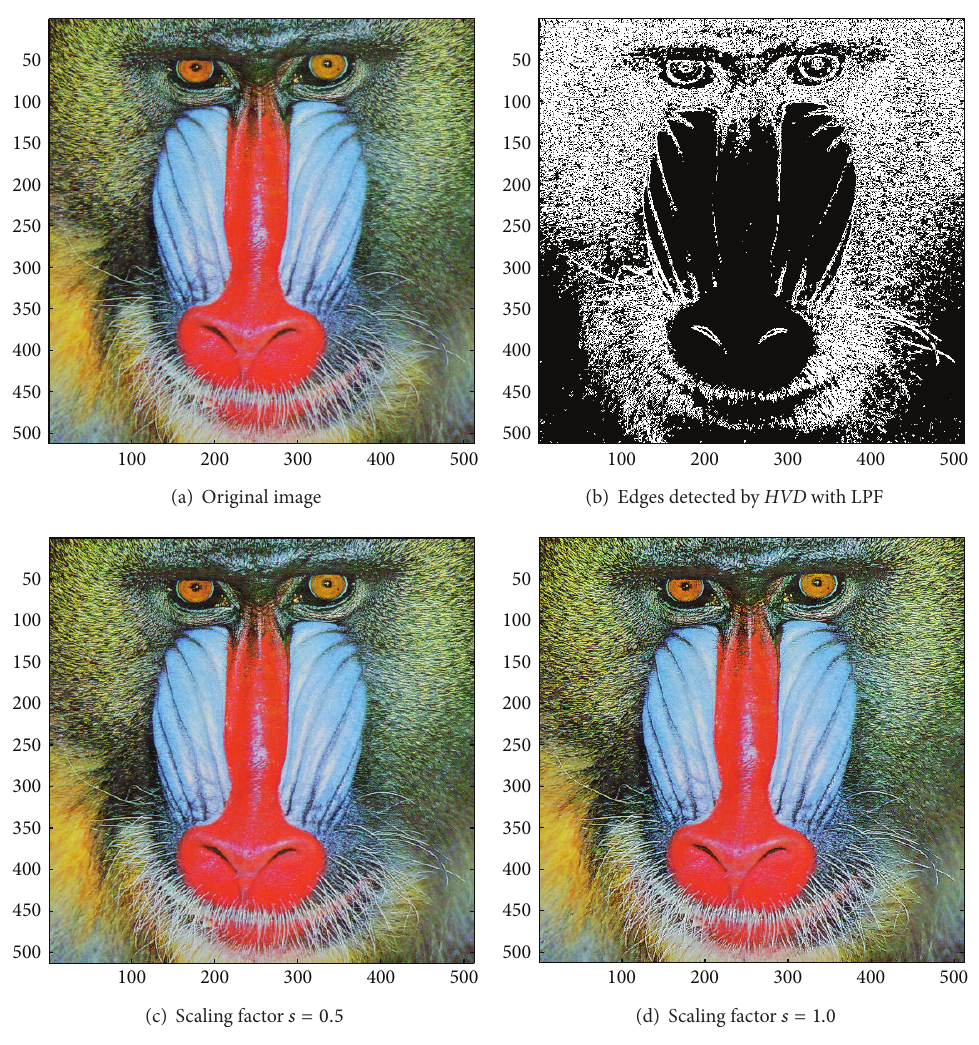
= 16 for HVD . (a) The image “Baboon” (512 × 512 color image). (b) Edges detected by HVD with LPF. (c and d) Sharpened Figure 11: 𝜃 eth results by HVD with scaling factors 0.5 and 1.0 ,